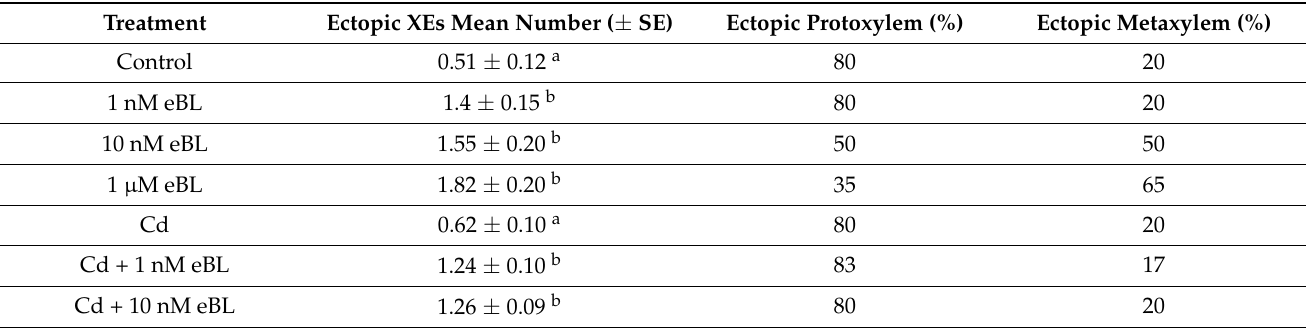
Table 1. Quantification of ectopic xylary elements (EXEs) detected in the basal hypocotyl of A. thaliana (Col ecotype) seedlings cultured for 9 days under continuous darkness followed by 7 days under 16 h light/8 h darkness photoperiod either in a hormone-free medium (Control), or with 1 nM of 24-epibrassinolide (eBL), 10 nM eBL, 1 µ M eBL, 60 µ M CdSO 4 (Cd), 60 µ M Cd + 1 nM eBL, or 60 µ M Cd + 10 nM eBL. Mean number [ ± standard error (SE)] of EXEs and percentage of ectopic protoxylem and metaxylem elements detected in an area of 150 × 150 µ m 2 in the middle portion of the basal hypocotyl. Letters indicate significant differences among values at least at p < 0.05. The same letter shows no significant difference. N =